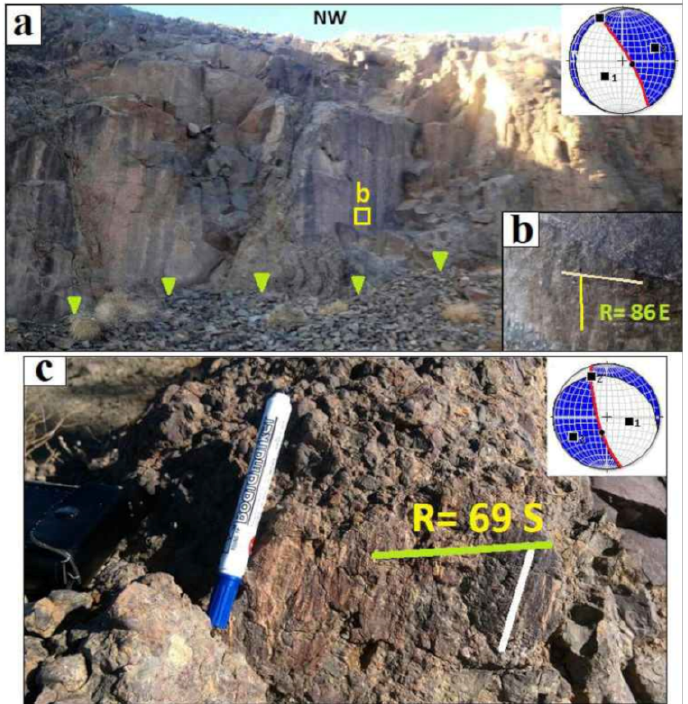
Figure 8. ( a ) Field photo of the F18 fault trace that is normal with a sinistral strike-slip component. ( b ) Slickenline on the minor fault in part. ( c ) Field photo of the F25 fault that is normal with a dextral component. Numbers 1, 2, and 3 in the stereonet indicate the orientation of the maximum, medium, and minimum stress axes,